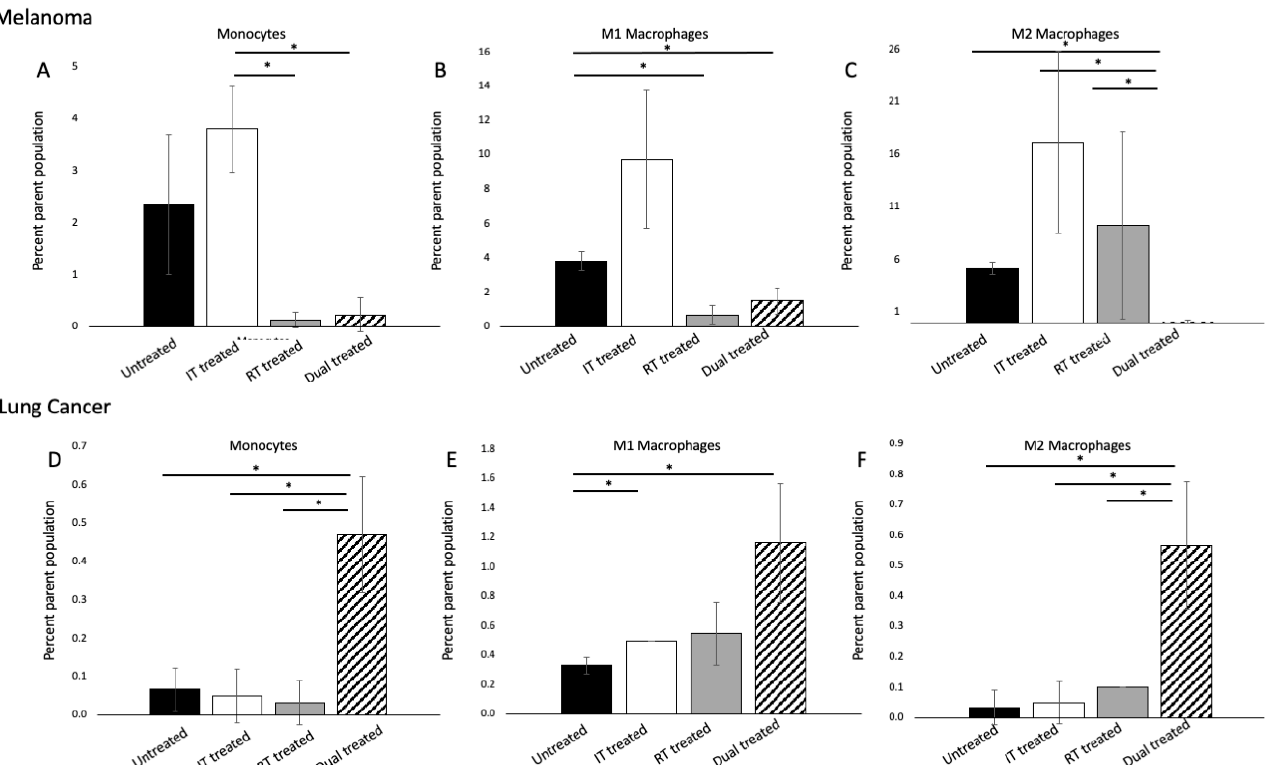
Figure 4. Flow cytometric analysis of myeloid lineage cells. In melanoma, ( A ) significant differences were seen among monocyte populations. In ( B ), M1 macrophages were significantly reduced in dual-treated samples compared with untreated tumors, and in ( C ), the M2 population was abrogated with combined therapy. In lung cancer, combined therapy led to significant increases in both monocytes, M1, and M2 macrophages compared with either treatment alone ( D – F ) ( n = 3 per group). Significant differences are marked with a line with an asterisk. (M1 macrophages: CD80 + /CD11b + ; CD11B + /CD206 + ). Supplemental Figure S2 presents an example flow gating strategy for myeloid cell